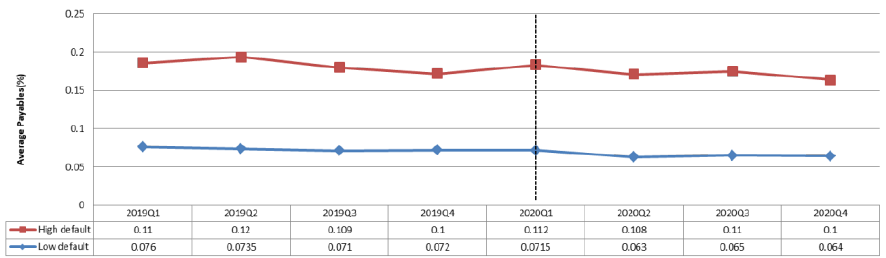
Figure 4. Parallel trend of average payables during the COVID-19 period.